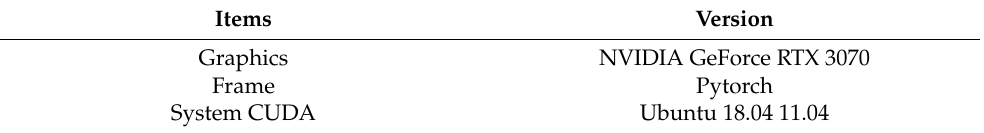
Table 1. Training Environment.